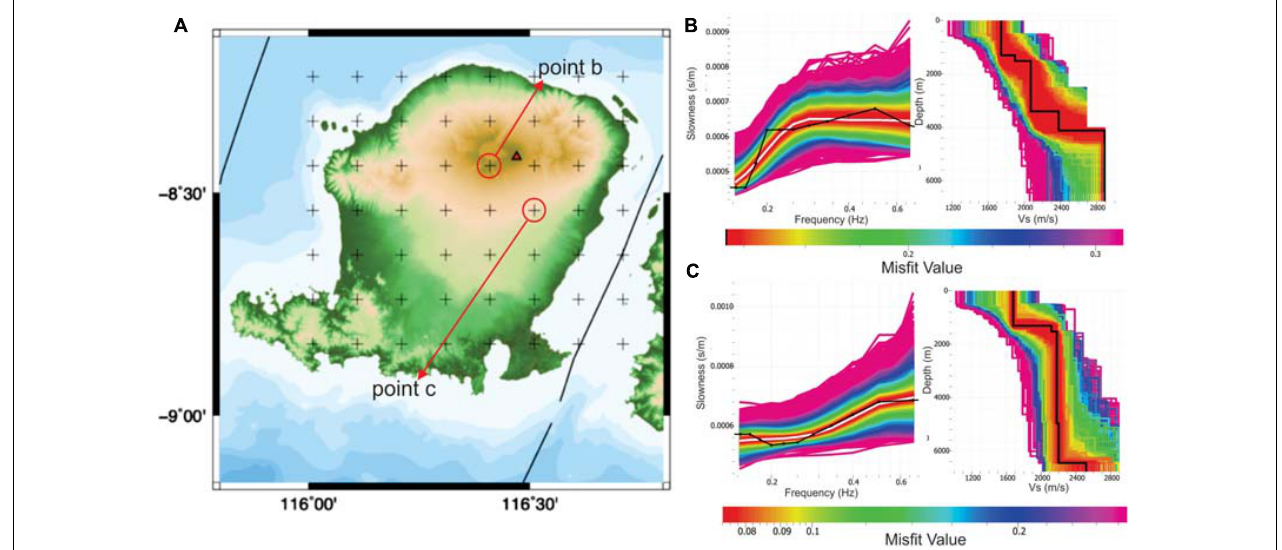
FIGURE 9 | Depth profile of Vs gained using Neighborhood Algorithm by dinver package of Geopsy. (A) Grid points of 1D Vs on this study area are shown in B,C . (B) 1D Vs profile at point 116.41 ◦ and 8.44 ◦ . (C) 1D profile at point 116.51 ◦ and 8.54 ◦ .